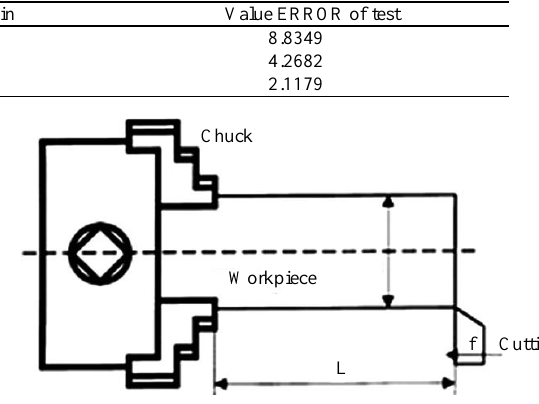
Figure 1. Workpiece clamped by a chuck in turning [26]. Figure 3 illustrates the diameter measurement positions along the workpiece, conducted by Bendaros et al . [23] after the longitudinal turning of a cylindrical part. Four different measurement positions along the axis of the workpiece were chosen at distances of 20, 70, 100, and 150 mm from the free end of the